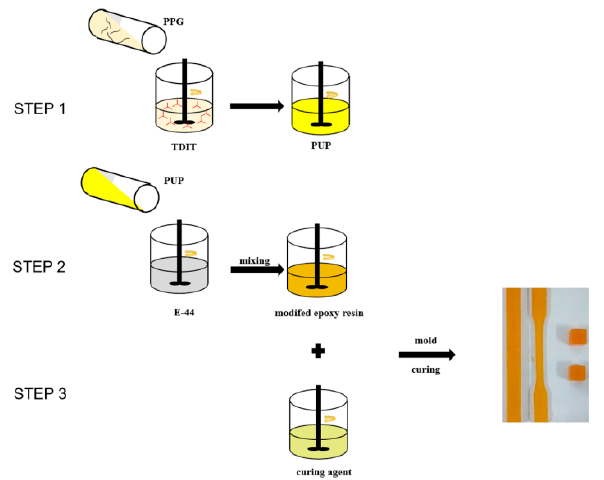
Figure 1. Flow chart of the synthesis and curing of the modified epoxy resin. TDIT: 2,4-toluene diisocyanate trimer, PPG: Polypropylene glycol.